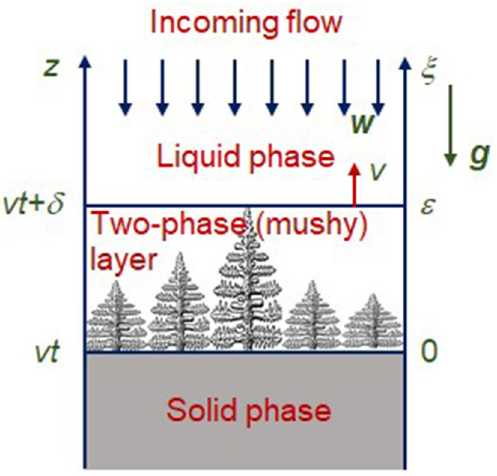
Figure 1. A scheme of directional steady-state crystallization with a mushy layer in the presence of incoming flow. The origin of moving coordinate system is at the boundary solid phase—two-phase